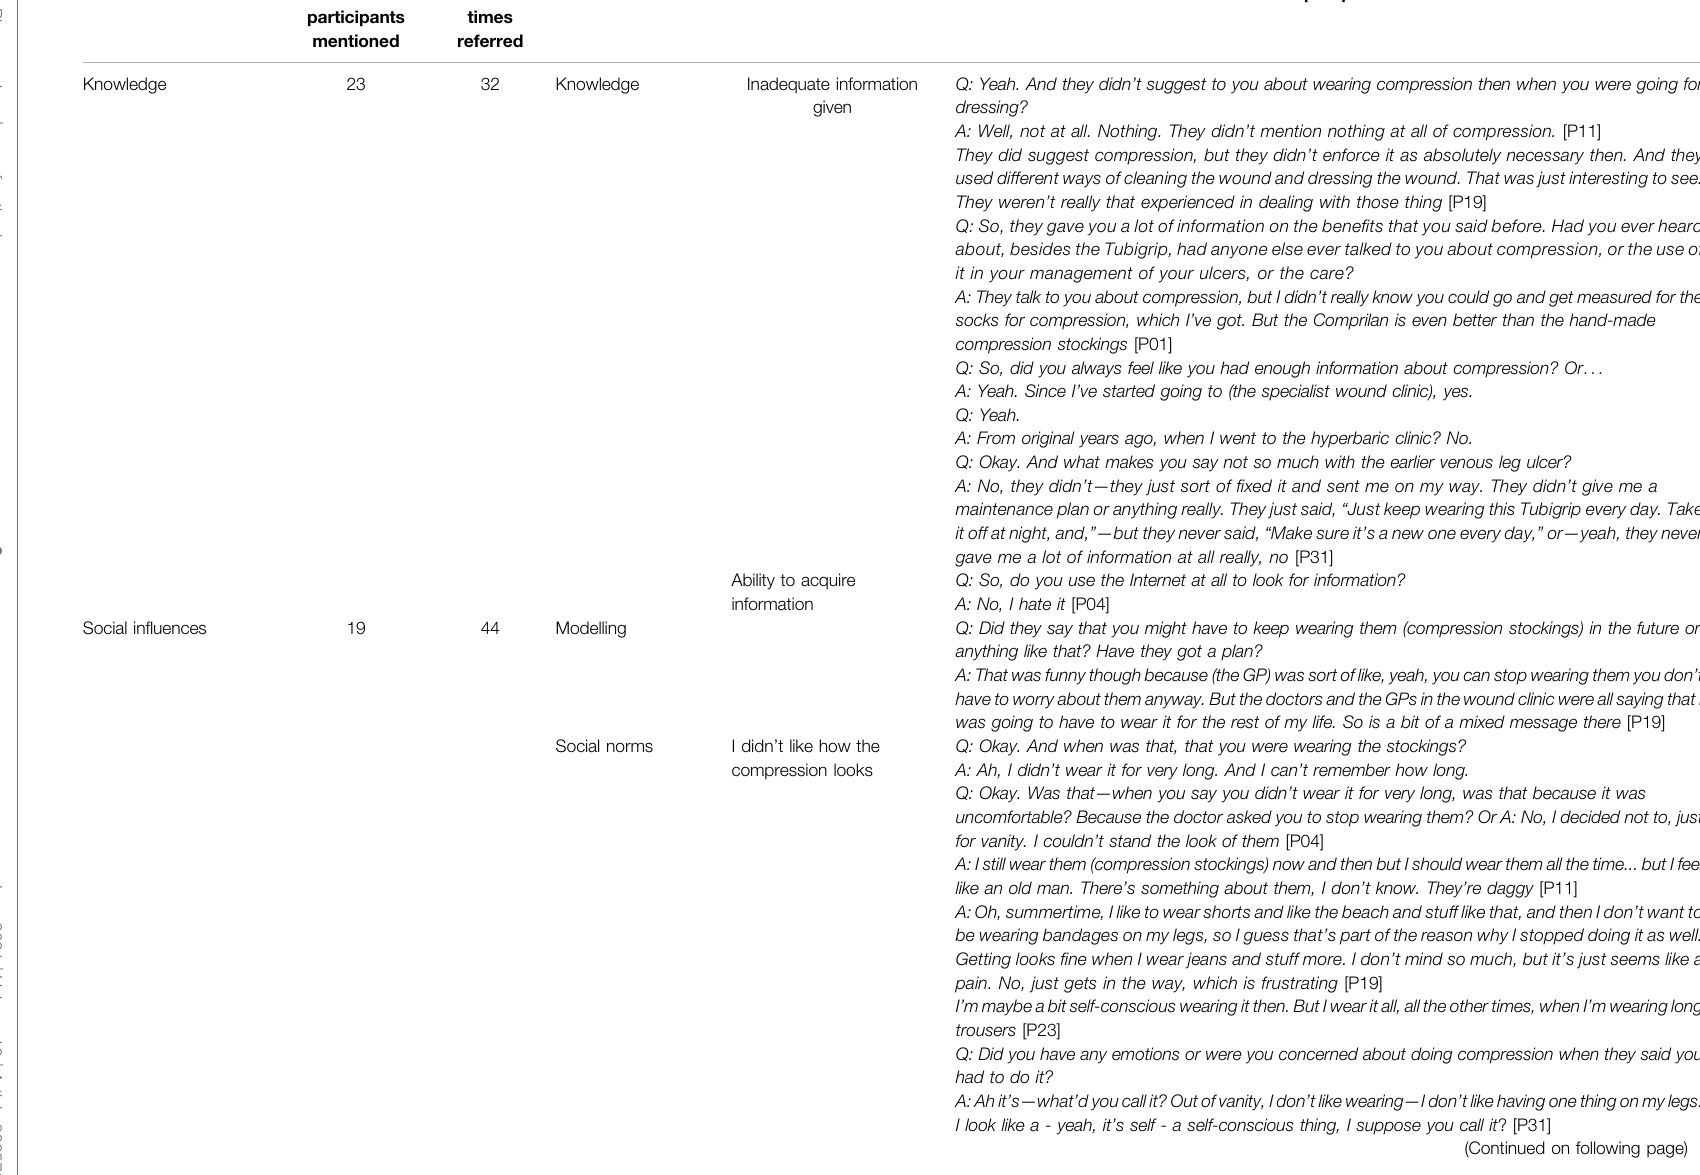
TABLE 3 | Barriers to patients ’ adherence to the evidence-based guideline recommendations for venous leg ulcer